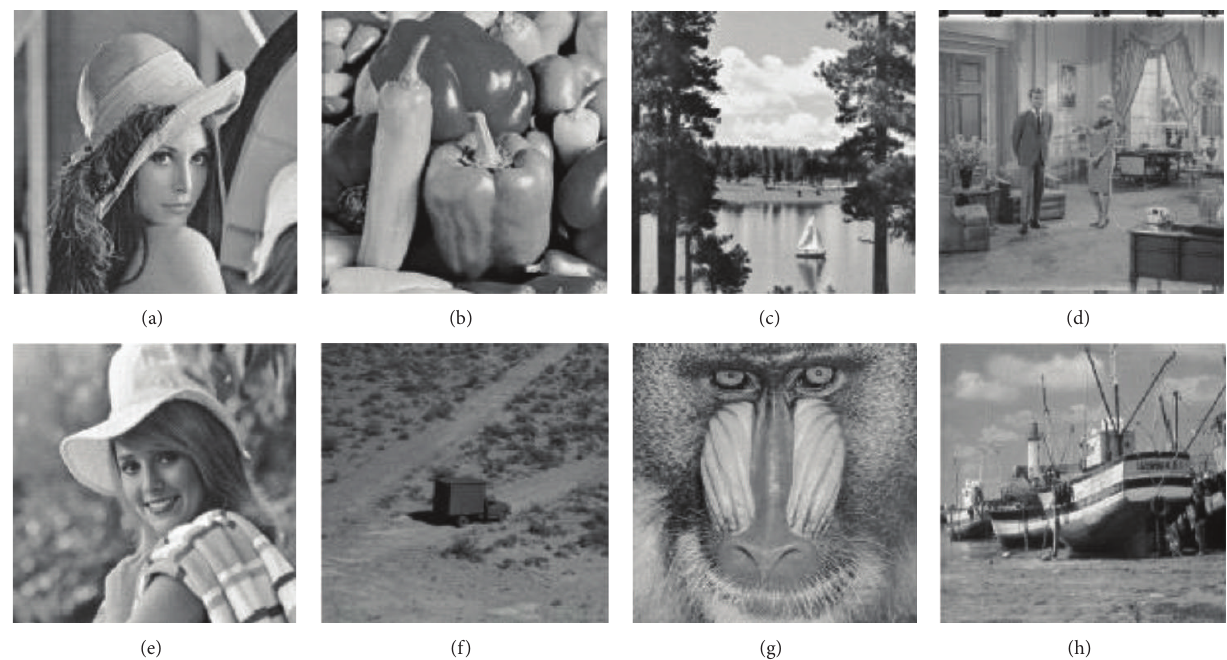
Figure 2: Selected images used in our experiment. (a) Lena, (b) pepper, (c) sailboat, (d) couple, (e) Elaine, (f) trunk, (g) mandrill, and (h) ship (all images are from USC-SIPI).